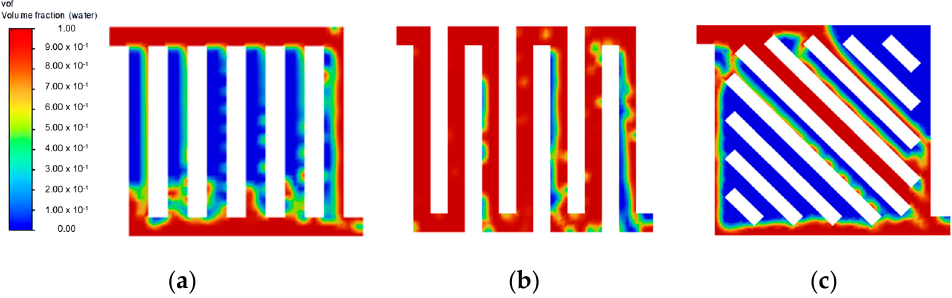
Figure 3. Steady state flow distribution at velocity = 0.25 m · s − 1 : ( a ) parallel; ( b ) serpentine; and ( c ) symmetry.